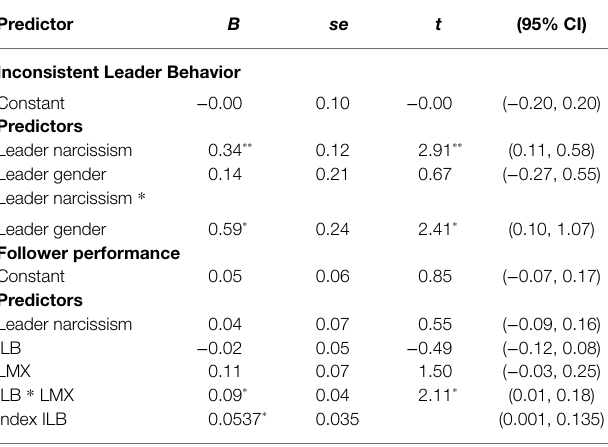
TABLE 3 | Results of the moderated mediation analysis using the PROCESS macro 21. Predictor